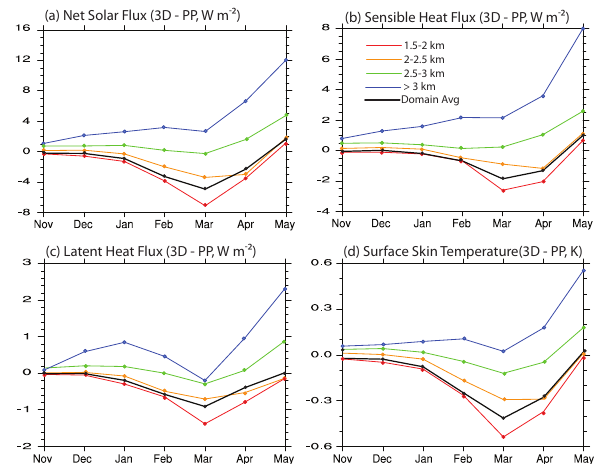
Fig. 10 Fig. 10. Deviations (3-D-PP) of the domain-averaged monthly (a) net solar flux, (b) sensible heat flux, (c) latent heat flux, and (d) sur- face skin temperature for a 7-month period (November 2007–May 2008) as a function of elevation. 1.5–2km (red), 2–2.5km (orange), 2.5–3m (green), above 3km (blue), and the whole domain